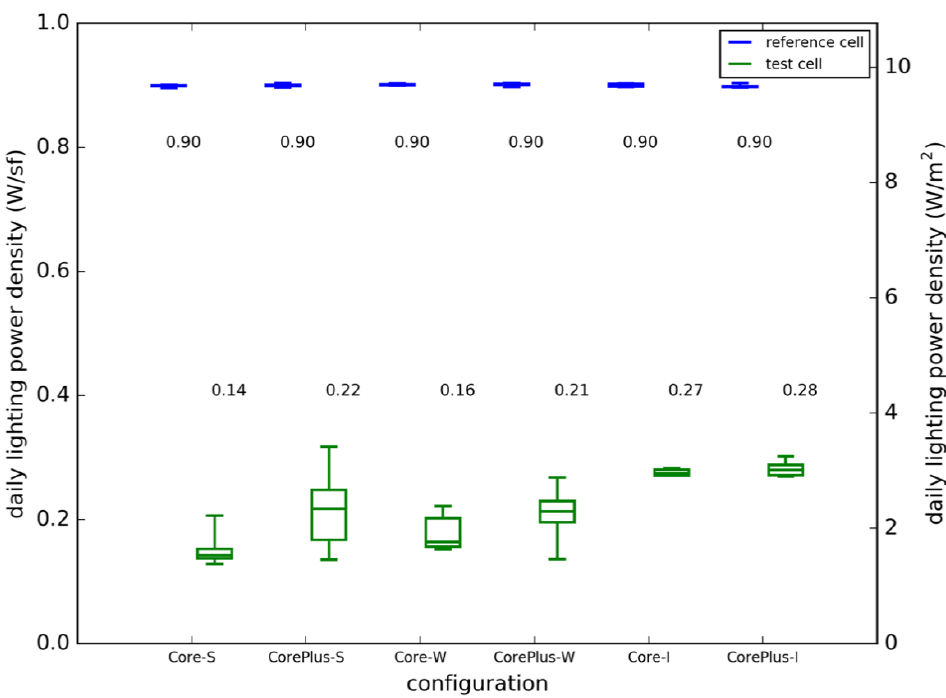
Figure 7. Average lighting power density (W / sf) during occupied hours for reference and test cases for each configuration. (Numbers inside the chart are median values in W /